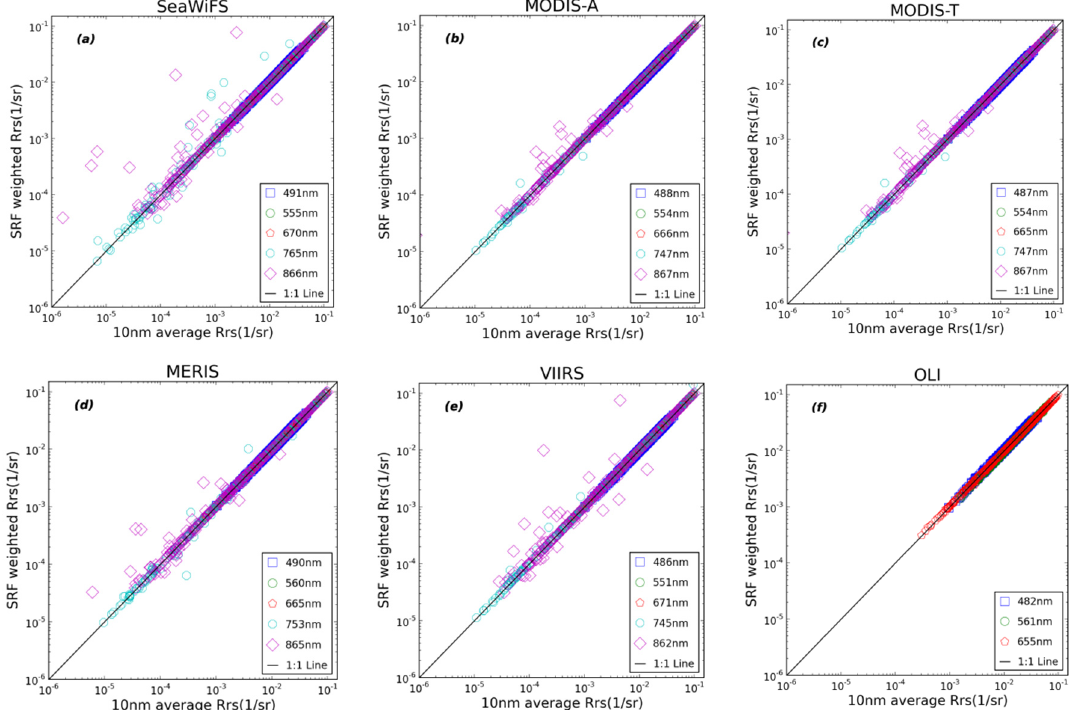
Figure 12. Comparison between the R rs values averaged over a 10nm-bandwidth, and those calculated using the Spectral Response Functions for the ( a ) SeaWiFS; ( b ) MODIS-Aqua; ( c ) MODIS-Terra; ( d ) MERIS ( e ) VIIRS and ( f ) OLI sensors for visible and near-infrared channels, as indicated. Solid lines represent the 1:1